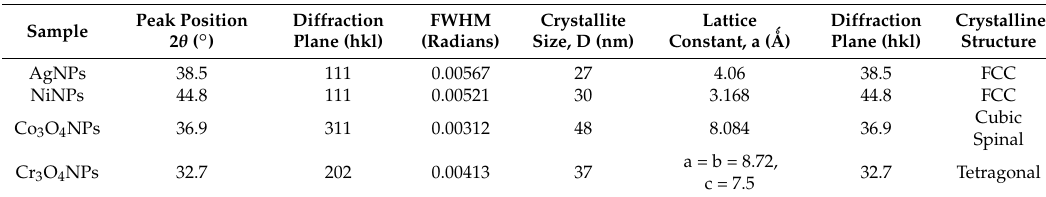
Table 1. Calculated structural properties of synthesized NPs.